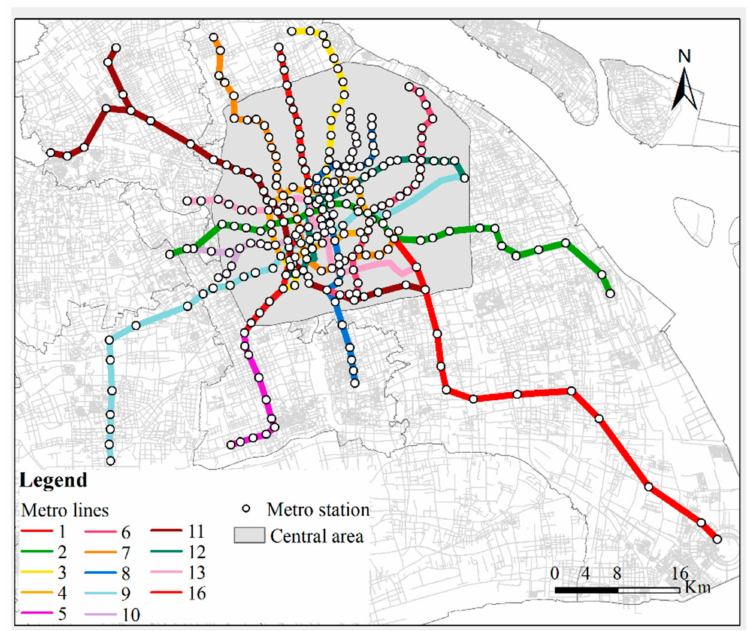
Figure 4. Study areas and the metro system in Shanghai